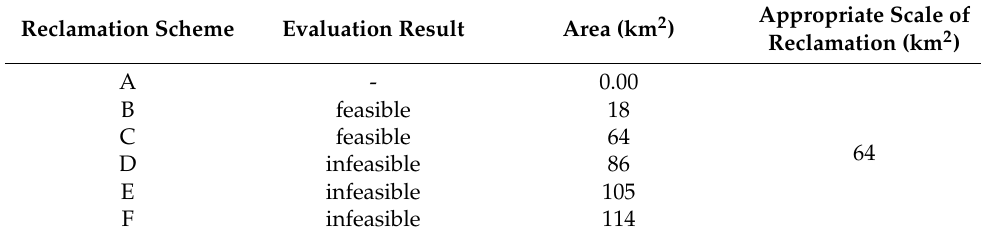
Table 17. The maximum allowable area for CR in Haizhou Bay (scenario 2).